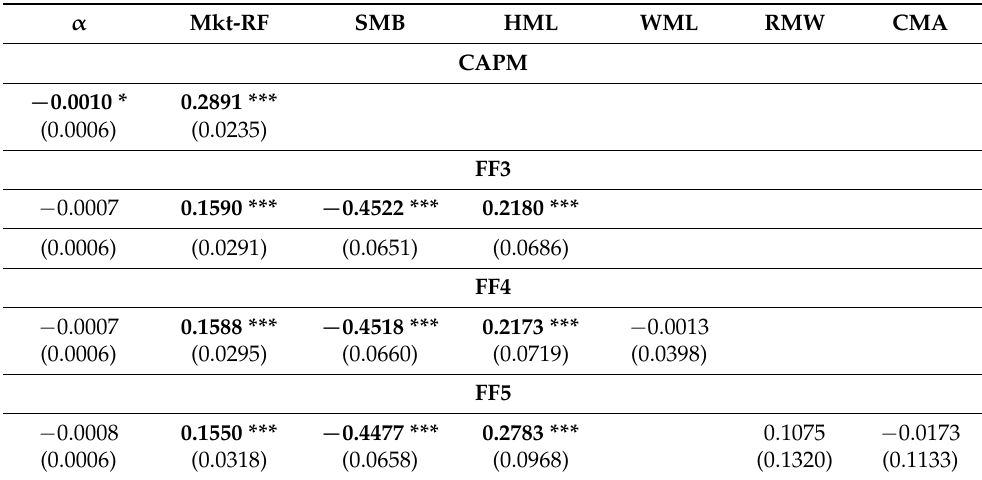
Table 5. Regression results of CAPM, FF3, FF4 and FF5 models for the period 2003–2019 using the Oestrich and Tsiakas criterion